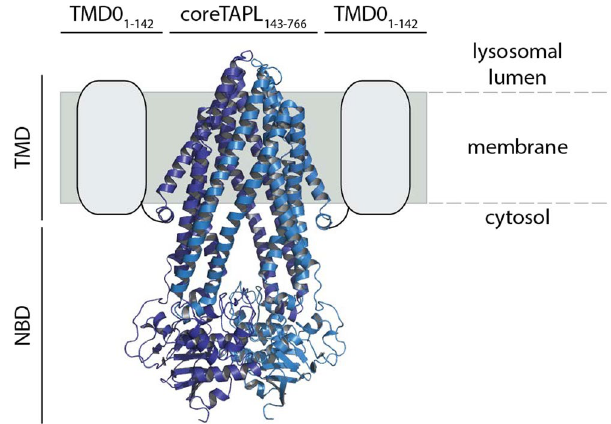
Figure 1. Architecture of homodimeric TAPL complex. Functionally, the half-size transporter TAPL can be divided in an N-terminal TMD0 (grey box), which is essential for lysosomal targeting and the interaction with LAMP-1/2, and coreTAPL (light and dark blue) composed of six TMHs and a C-terminal, cytosolic NBD. CoreTAPL forms dimers and is fully active in peptide transport but mislocalized to the plasma membrane. CoreTAPL was modeled with SWISS-MODEL on the X-ray structure of ABCB10 (PDB ID: 4YAT) 40,41